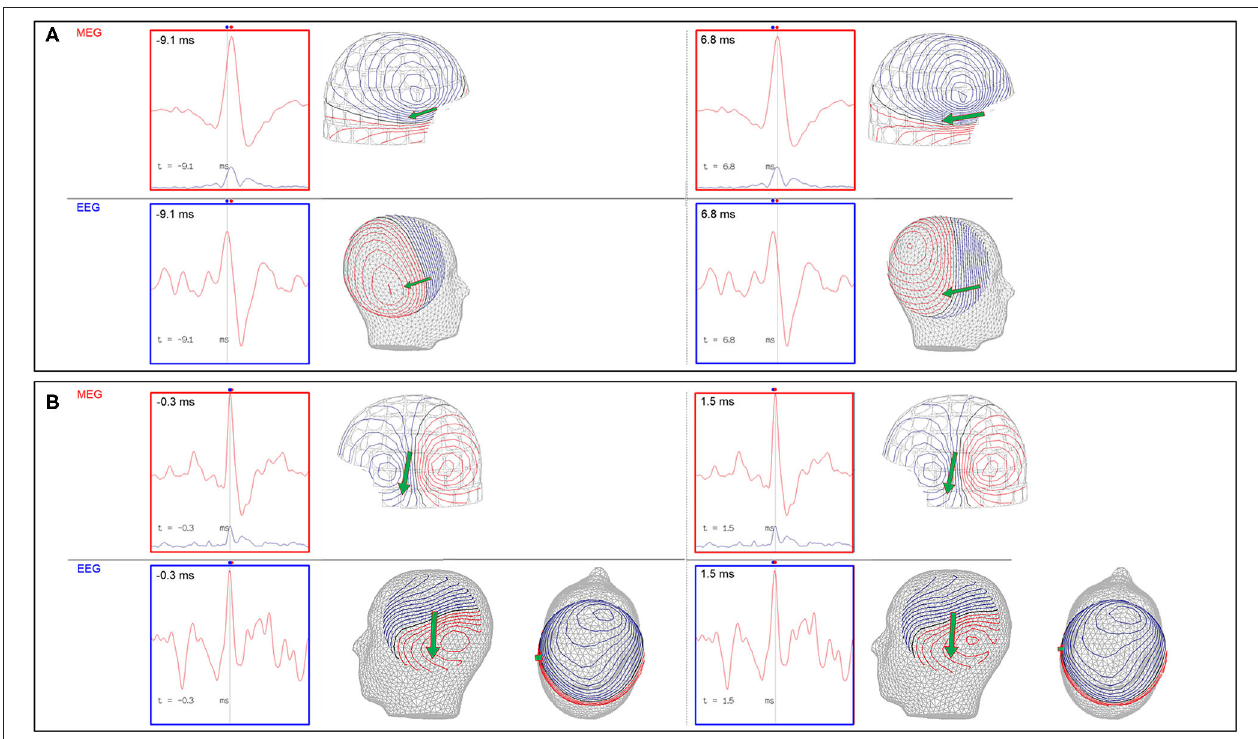
FIGURE 5 | Importance of MEG-EEG integrative analysis (red dots: time of MEG peaks; blue dots: time of EEG peaks; green arrow: MEG source localization). (A) Right temporal MEG spike peak lags that of the EEG (15.9ms). Although the dipoles are congruent, the earlier EEG spike with an anterior field pattern raises the possibility of a preceding anterior source. (B) Left temporal MEG spike without a significant MEG-EEG peak latency difference. Although this patient’s 22-channel scalp EEG tracing showed bifrontal maximal negativity, this EEG field pattern can be explained by both the MEG and EEG dipole